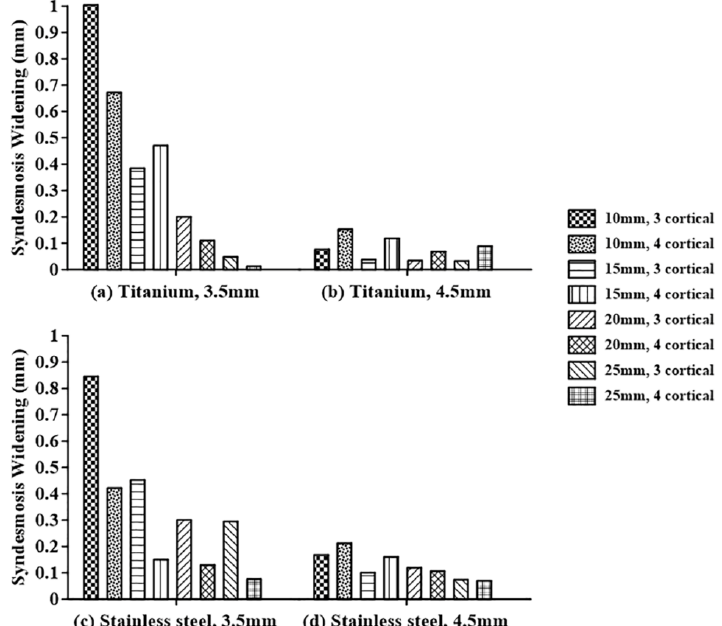
Figure 14. Analysis of the syndesmosis widening in terms of the number of penetrated cortical bones: ( a ) titanium screw with a diameter of 3.5 mm, ( b ) titanium screw with a diameter of 4.5 mm, ( c ) stainless steel screw with a diameter of 3.5 mm, and ( d ) stainless steel screw with a diameter of 4.5 mm.